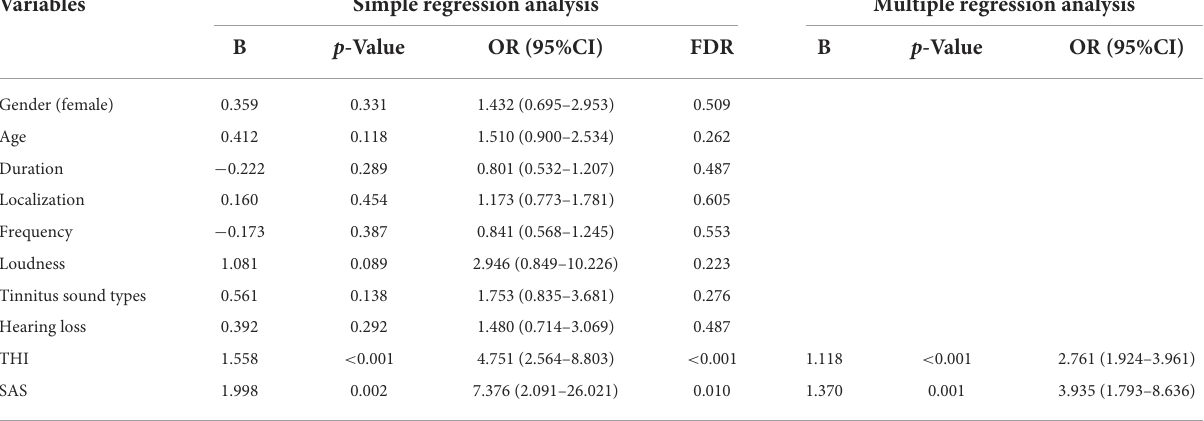
TABLE 3 Logistic regression results for risk factors associated with sleep disorders.